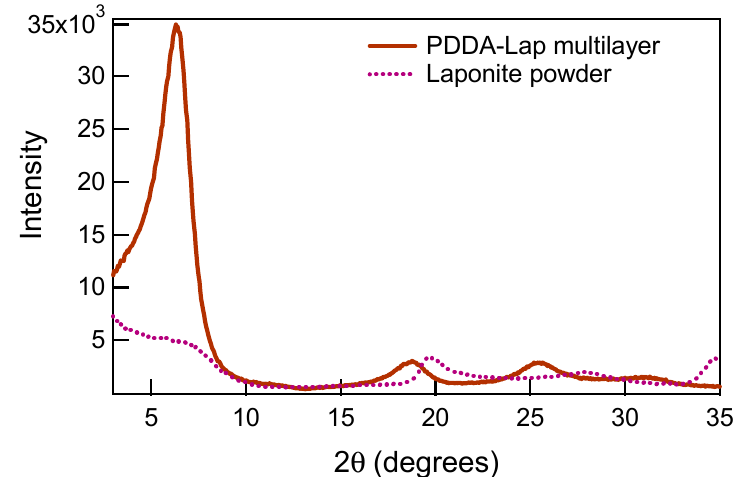
Figure A3. Photograph of a 180-layer PDDA-PAA-PDDA-Laponite free-standing film. (Size ~2 cm × 2 cm).